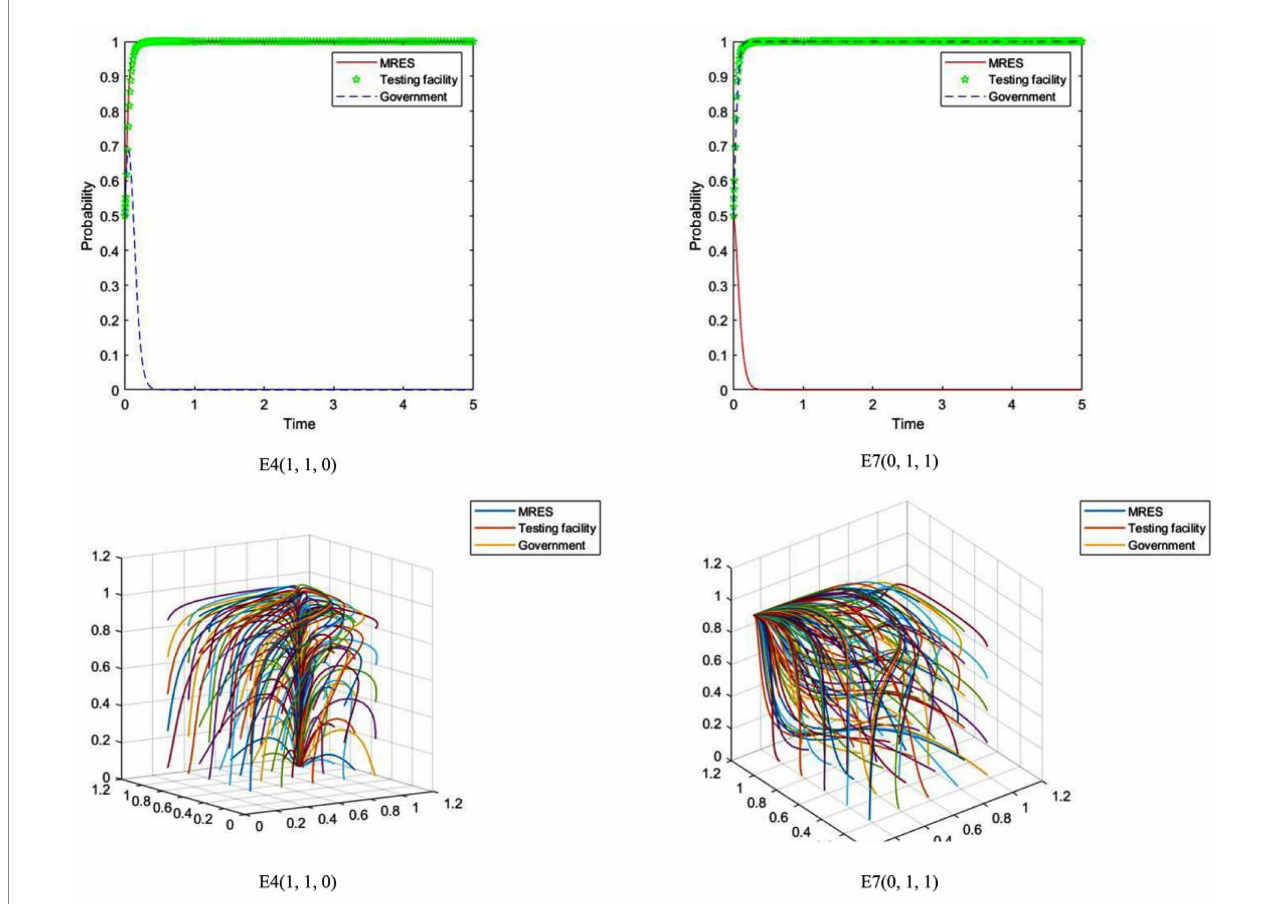
FIGURE 2 Two-dimensional path evolution and three-dimensional path evolution diagrams of equilibrium points E4(1, 1, 0) and E7(0, 1,